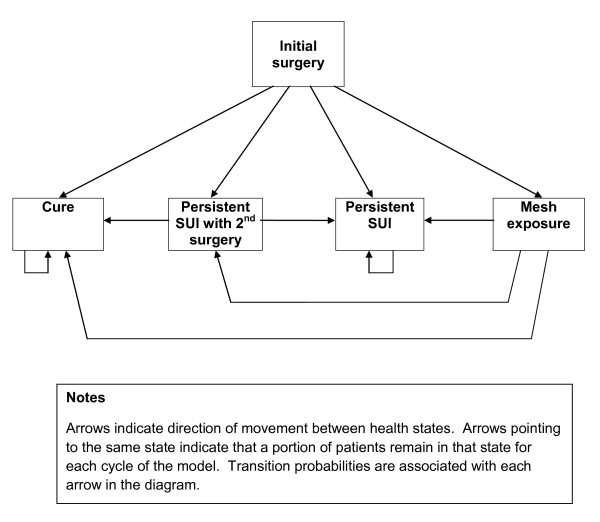
Illustrative Markov model structure [53].